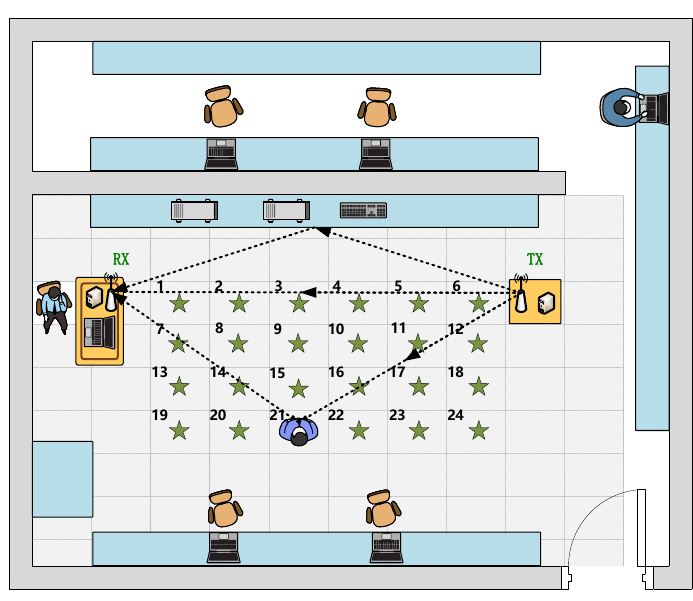
Figure 2. The layout of data collection